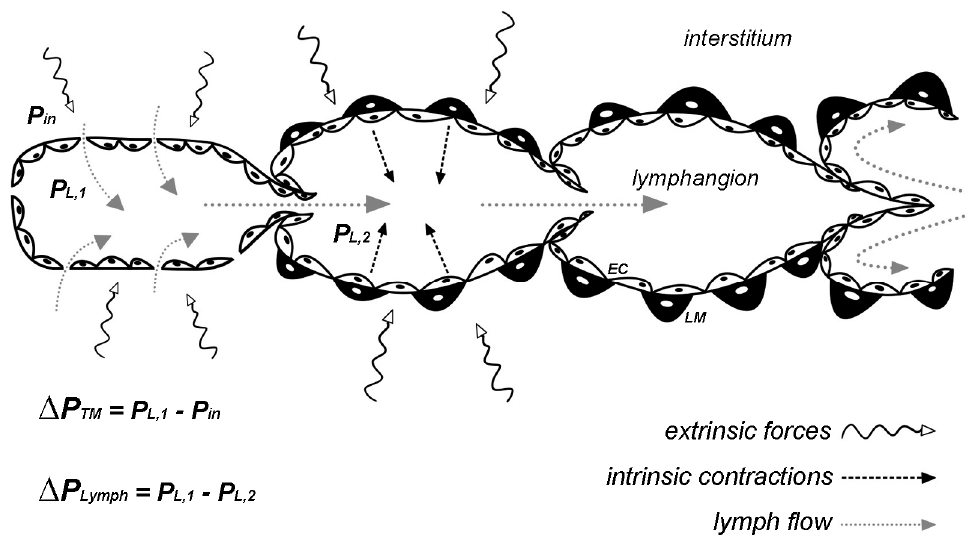
Figure 1. Functional scheme of how lymph is drained and propelled. Extrinsic forces and / or intrinsic rhythmic contractions generate transmural pressure gradients ( ∆ P TM ) across the wall of initial lymphatic capillaries and intraluminal pressure gradients ( ∆ P Lymph ) between adjacent lymphangions. Intraluminal valve leaflets are devoid of LM. ( P in ) interstitial hydraulic pressure; ( P L ) intraluminal hydraulic pressure; ( EC ) lymphatic endothelial cells; ( LM ) lymphatic muscle cells.